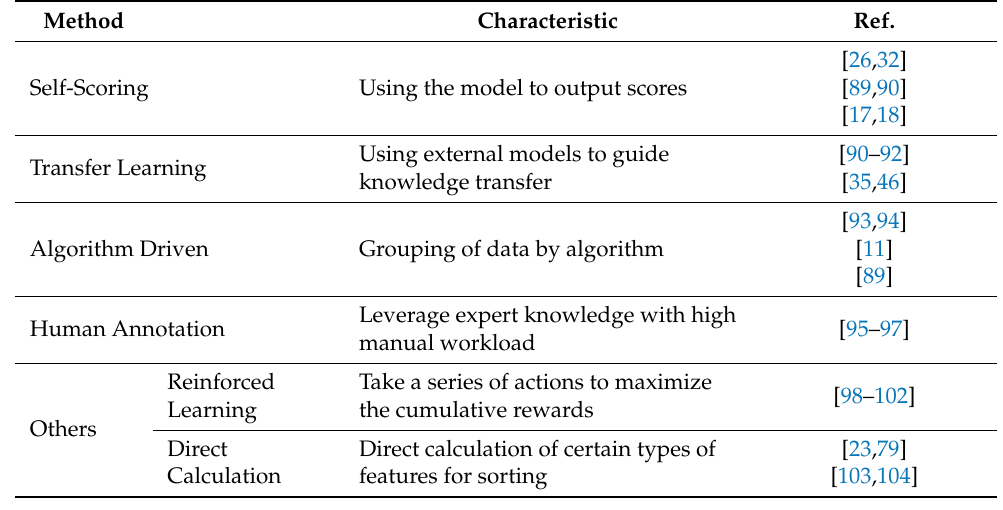
Table 1. Summary of non-heuristic difficulty